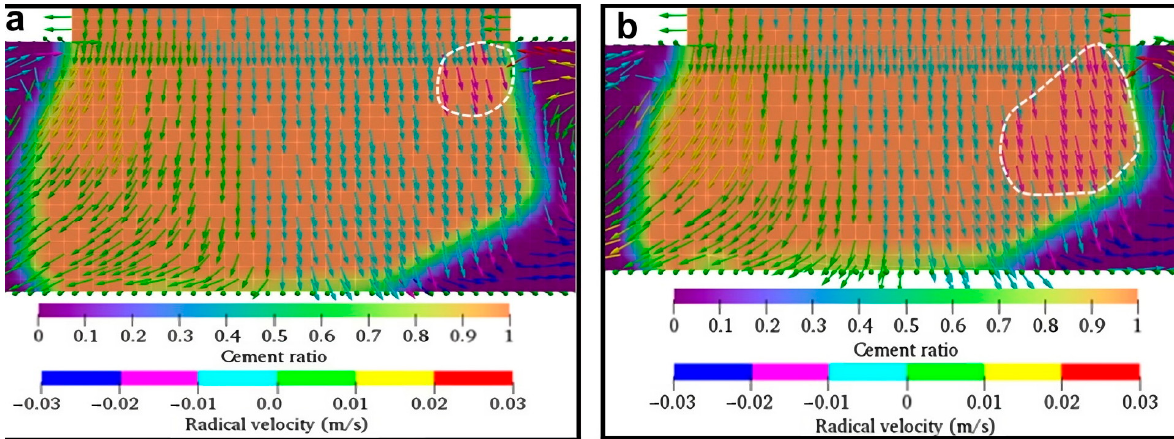
Figure 5. Cement ratio and velocity vector using a rectangular nozzle, R = 30 mm, ζ = 1.05, and φ of ( a ) 1.5 and ( b ) 2.